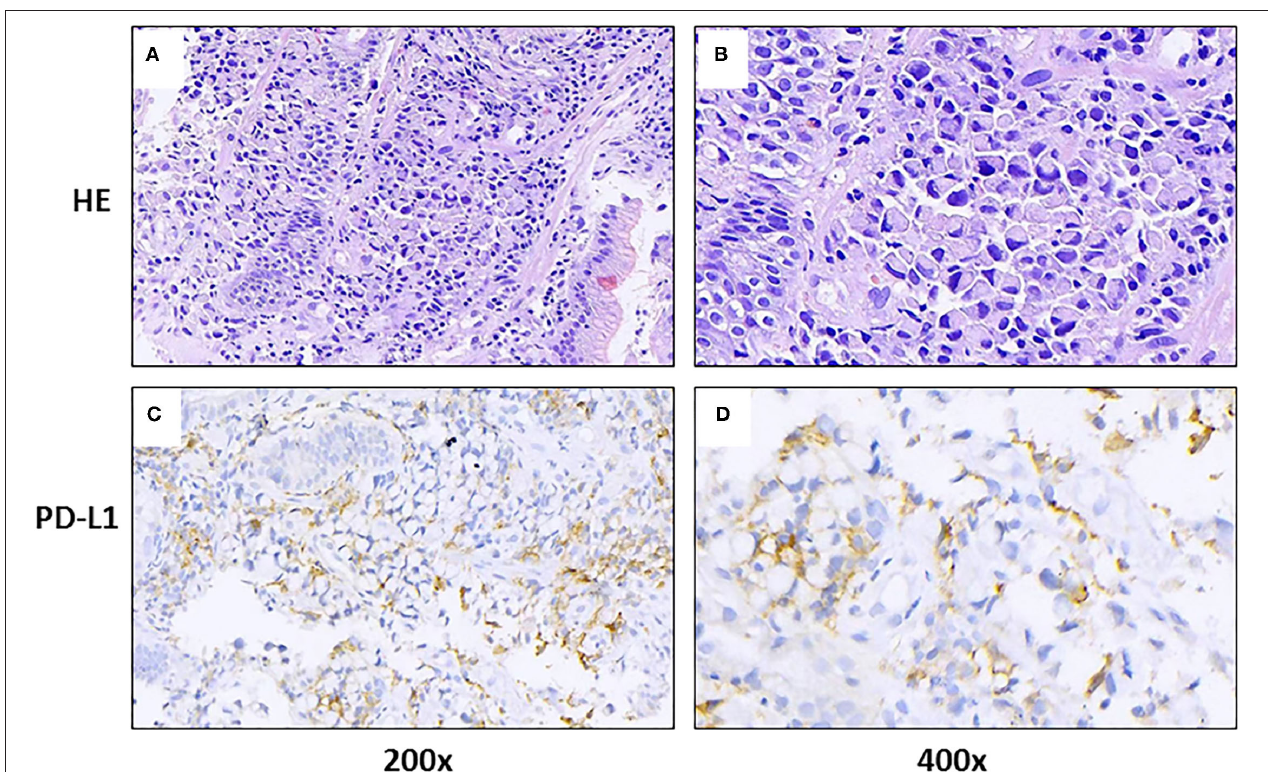
FIGURE 1 | Gastric tissue sections from a patient with metastatic gastric cancer and rare severe immune-related cholestatic hepatitis and subsequent severe late-onset pneumonia after pembrolizumab therapy. Representative photomicrographs show H&E staining (A,B) and immunohistochemical staining with programmed